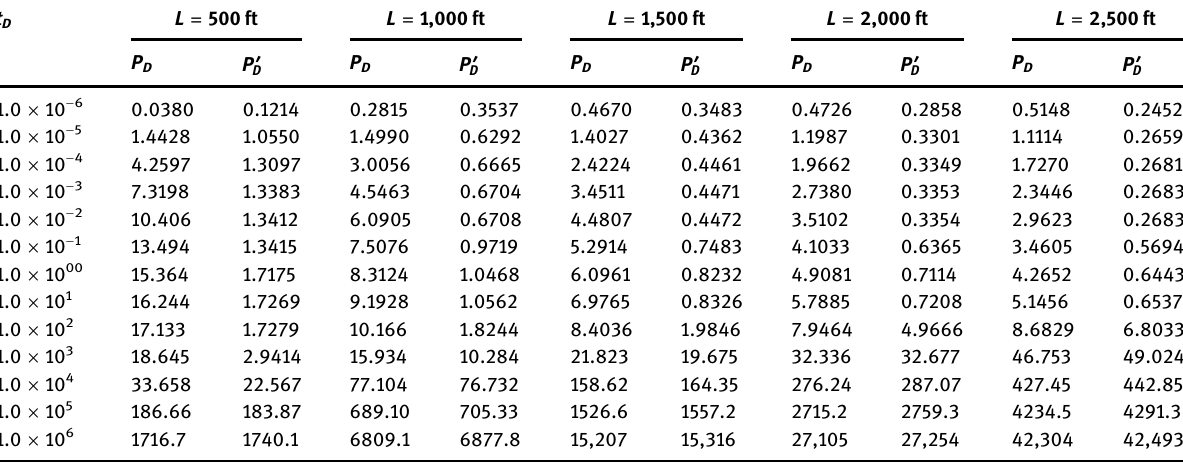
Table A3: Dimensionless pressure and dimensionless pressure derivative for varying L